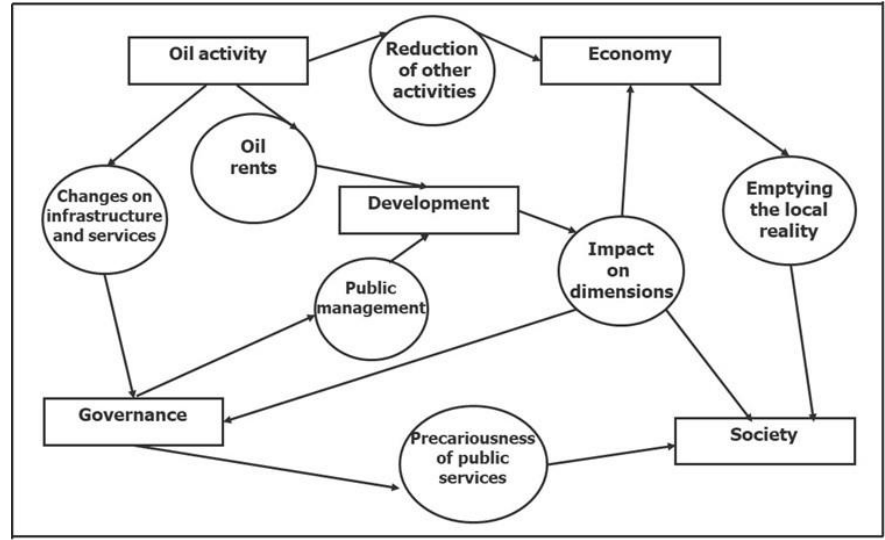
Figure 2. Oil, Municipal Government, and Development.